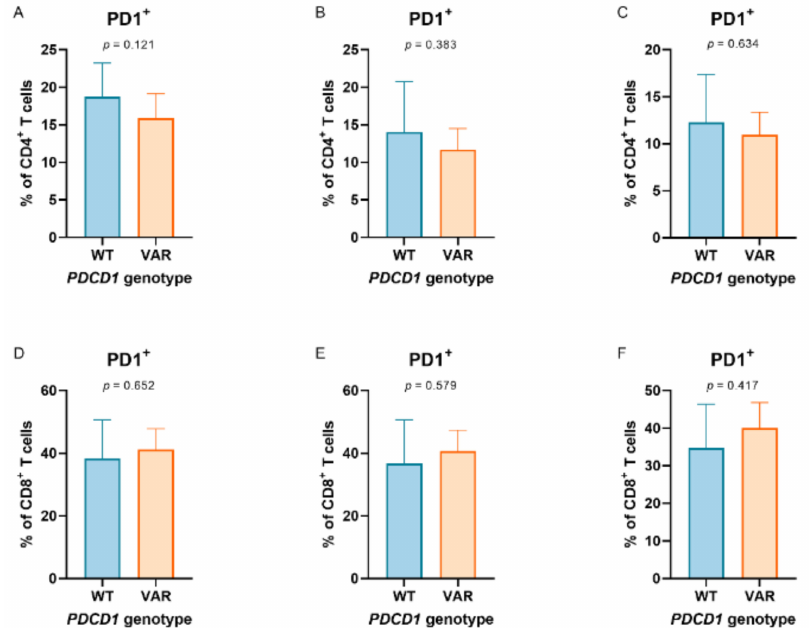
Figure 1. Programmed cell death 1 (PD-1) expression in peripheral T cell populations according to PDCD1 804C > T genotypes. PD-1 expression in peripheral ( A – C ) CD4+ and ( D – F ) CD8+ T cells according to PDCD1 804C > T genotypes (comparing wild types (WT) and heterozygous variants + homozygous variants (VAR)). Peripheral T cells were collected prior to (baseline, graphs on the left) and during anti-PD-1 monotherapy (mid: prior to the second administration of anti-PD-1 monotherapy; right: prior to the third administration of anti-PD-1 monotherapy) in patients with metastatic melanoma ( N =